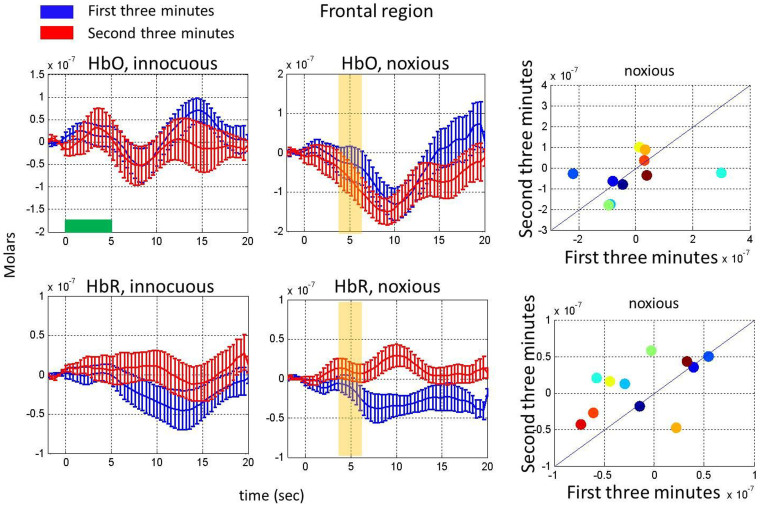
Habituation in the hemodynamic response to noxious stimuli on the frontal region.Comparison of HbO (top, left panels) and HbR changes (bottom, left panels) in response to innocuous and noxious electrical stimuli in the first three minutes (blue) with the HbO and HbR changes in the second three minutes (red). Error bars represent the standard error across subjects (n = 11). Yellow bars show the interval chosen to obtain the mean response depicted for each subject in the scatter plots and stars indicate a statistically significant difference. The right panels show scatter plots comparing the hemodynamic response averaged over the yellow bar during the first and second three minutes for HbO (top) and HbR (bottom). The horizontal green bar shows the stimulus duration.